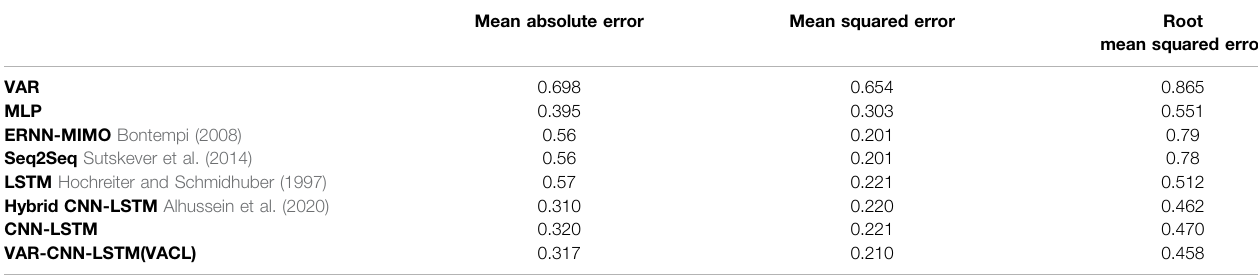
TABLE 2 | Combined results of all the algorithms on Household Data (Hebrail and Berard,